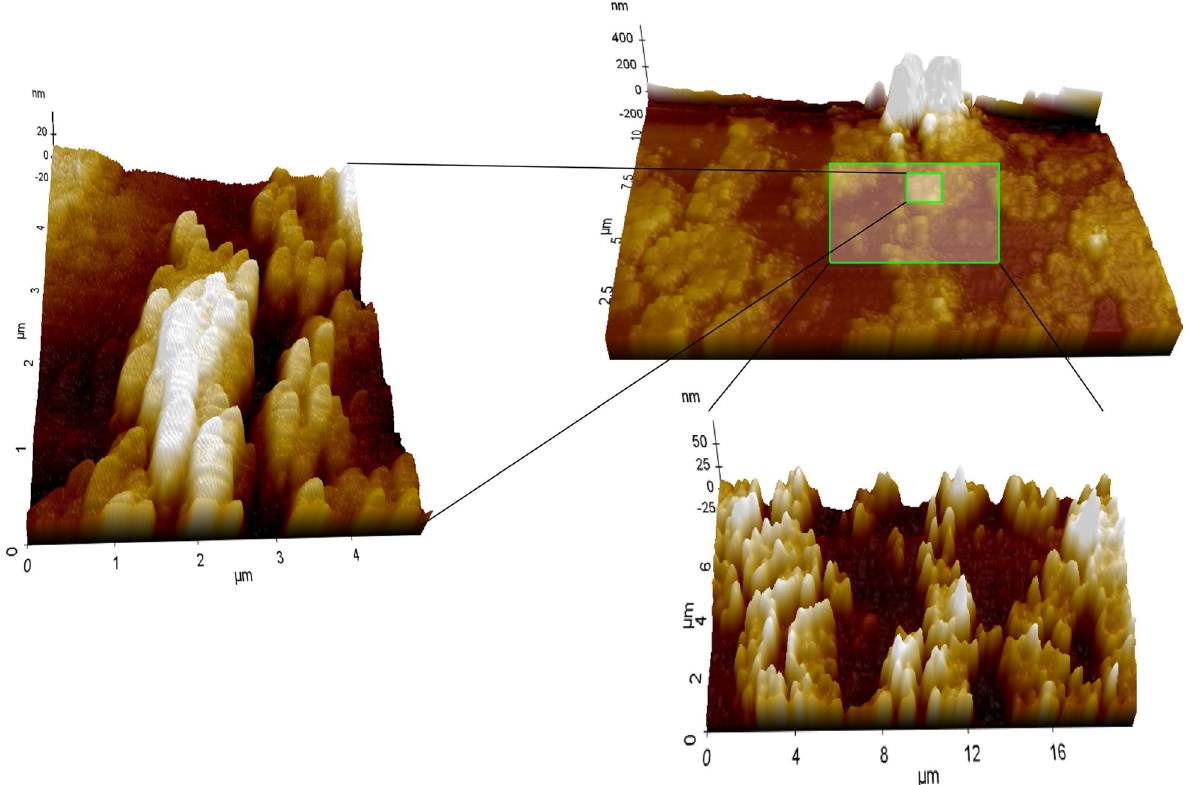
Fig. 9 AFM images of blank nanosponges